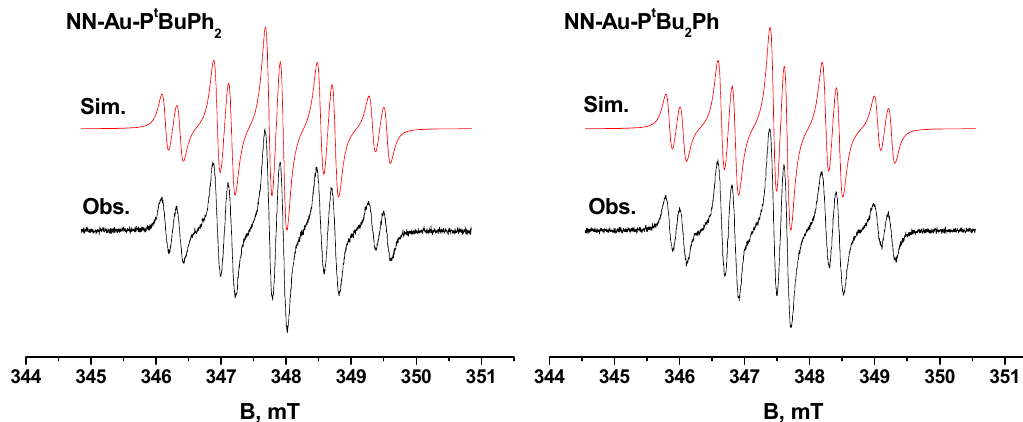
Figure 7. Simulated ( top ) and observed ( bottom ) ESR spectra for a solution of NN-Au-P t BuPh 2 or NN-Au-P t Bu 2 Ph in toluene.